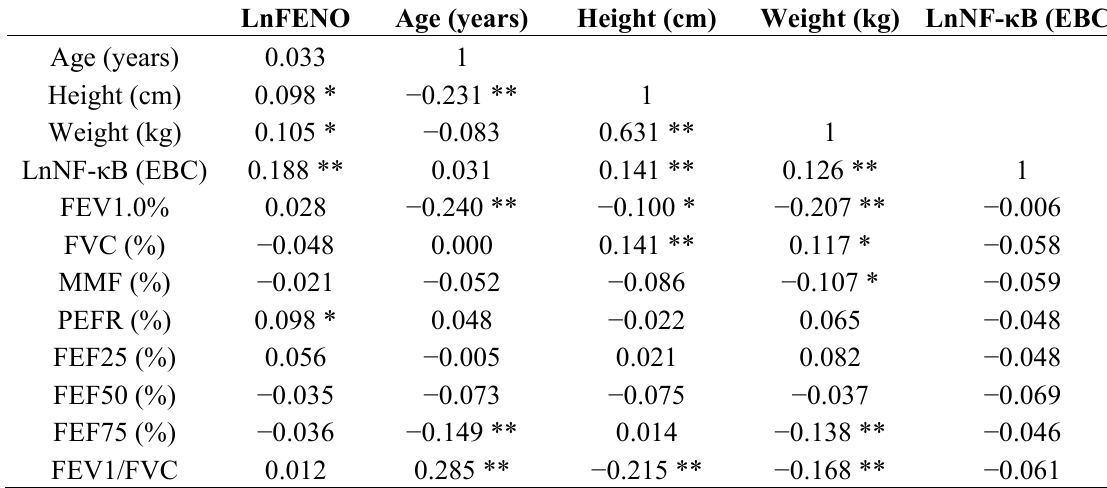
Table 2. Correlation matrix of LnFENO, age, height, weight, LnNF- κ B, and Pulmonary function ( n = 437).